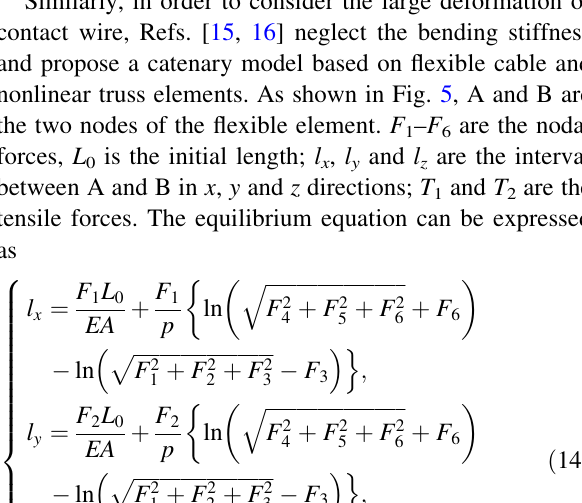
ffiffiffiffiffiffiffiffiffiffiffiffiffiffiffiffiffiffiffiffiffiffiffiffiffiffiffi q ffiffiffiffiffiffiffiffiffiffiffiffiffiffiffiffiffiffiffiffiffiffiffiffiffiffiffi F 2 þ F 2 þ F 2 4 6 5